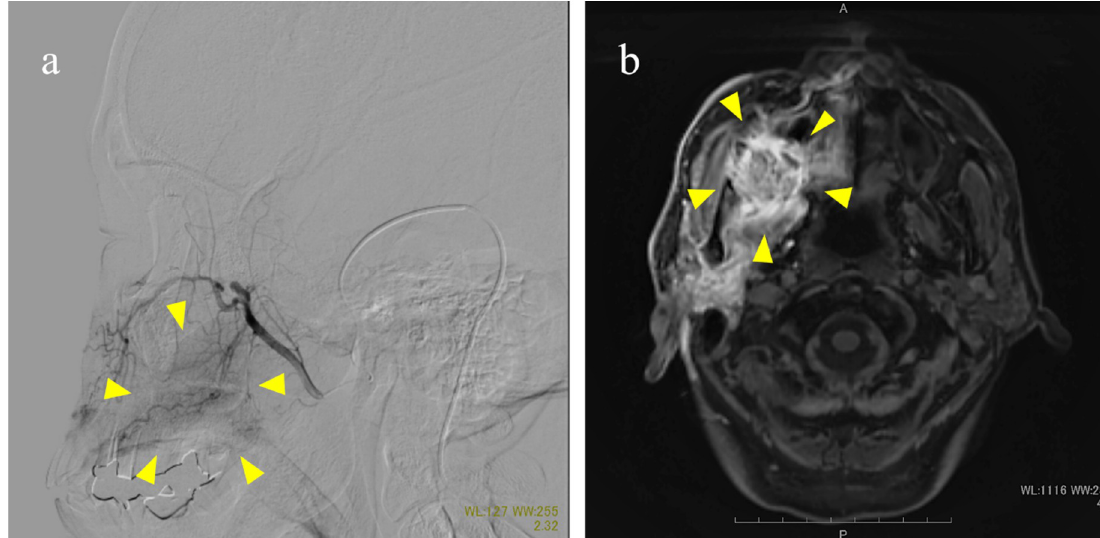
Figure 3. Methods to confirm flow using digital subtraction angiography ( a ) and magnetic resonance imaging ( b ). ( a ) The maxillary artery is displayed. Arrows indicate the labeled maxillary gingival tumor; ( b ) Perfusion of the right maxillary gingiva, palate, pterygoid muscle, and parotid gland. Arrows indicate the enhanced tumor. Scale bar: 10mm.